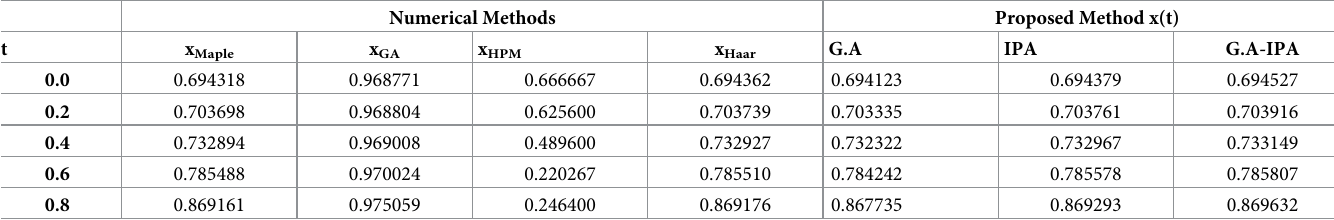
Table 6. Approximate solutions by numerical methods and proposed method for δ = 2.0.